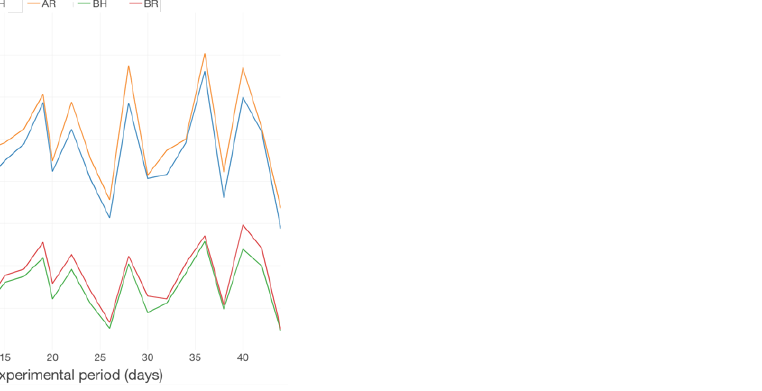
Figure 24. The dynamics of Mg concentration in technological water for each of the experimental variants.